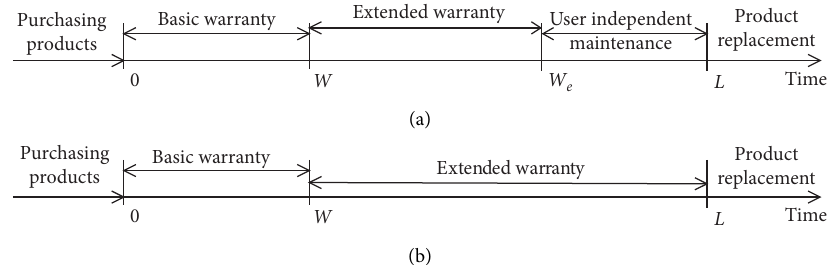
Figure 1: The partially outsourcing and the fully outsourcing modes of